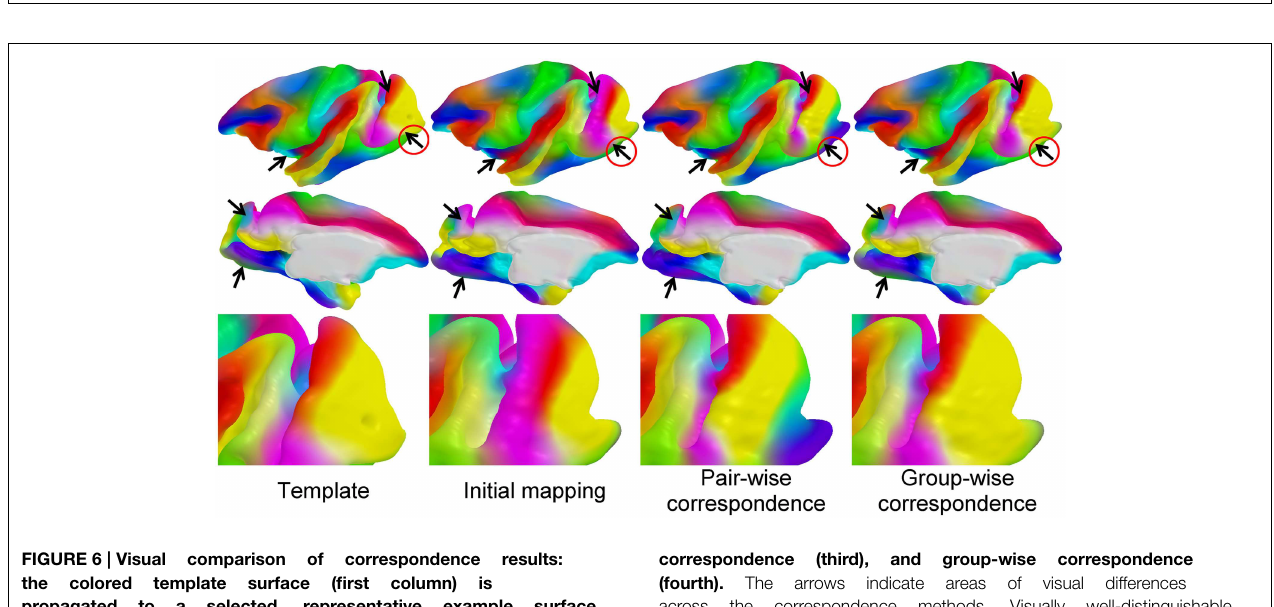
FIGURE 5 | Cortical surface coloring using spherical harmonic interpolation. An individual curve has its own color for propagation and the sulcal curves are then mapped onto the sphere. For each RGB